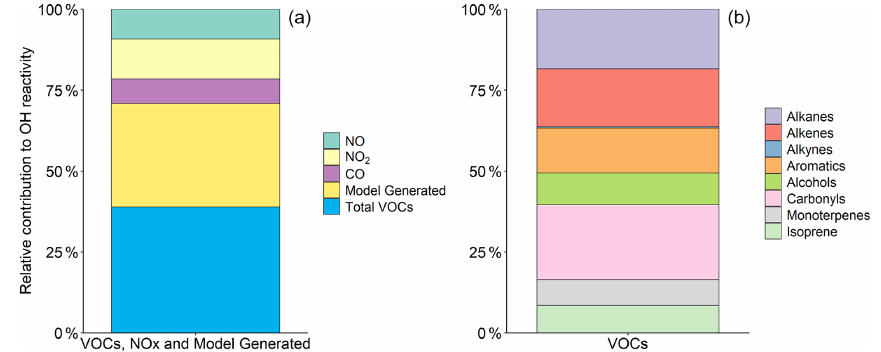
Figure 8. Relative contribution of species classes to average morning OH reactivity, k (OH), (08:00–12:00). The contribution of each group to the total k (OH) including NO x and model-generated species (a) and the contribution of each class to just the VOC proportion of k (OH) (b) .